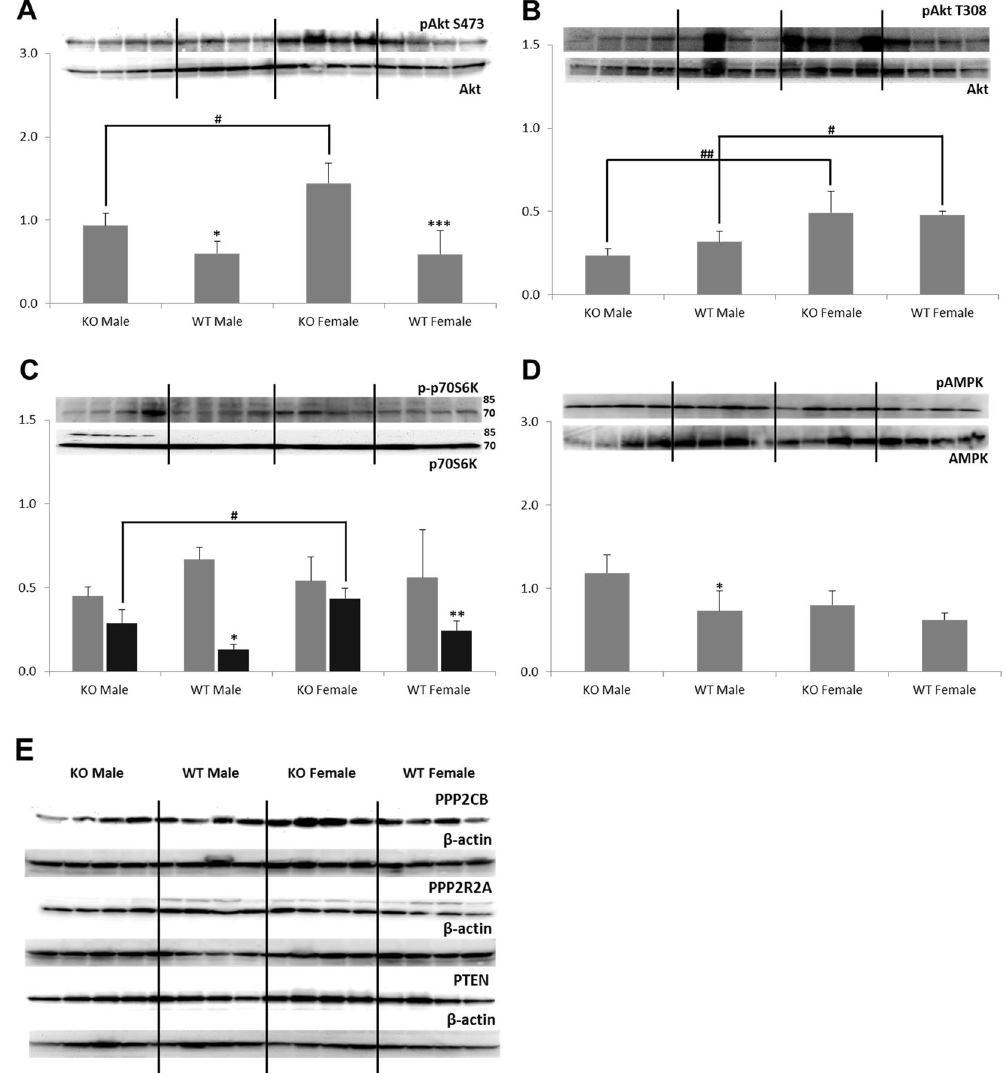
Figure 3. Western blot analysis of proteins involved in the regulation of glucose metabolism. ( A ) Activated Akt (presented as the phospho-Akt S473 to Akt ratio) was significantly higher in kidneys of Ppif − / − than in WT animals. ( B ) No change in the phospho-Akt T308 levels between Ppif − / − and WT animals was found. ( C ) The expression of phospho-p70S6 kinase T389 was higher in Ppif − / − animals and ( D ) so was expression of phospho-AMPK, however significantly only in males. ( E ) Expression of PP2A and PTEN proteins (with their respective β -actin loading controls) was similar among groups. Data is presented as average ± SD (n = 4). One-way ANOVA significances were as follows: (A) P < 0.001, (B) P < 0.001, (C) P = 0.363 and P < 0.001 for phospho-p70S6K/p70S6K 85 kD (grey bars) and 70 kDa (black bars) forms, respectively, (D) P = 0.006 and (E) P = 0.037 for PPP2CB, P = 0.009 for PP2R2A, and P = 0.281 for PTEN. Significance levels are: * p < 0.05, ** p < 0.01 and *** p < 0.001 for WT versus Ppif − / − animals (male and female); # p < 0.05 and ## p < 0.01 for male versus female in WT and Ppif − / −